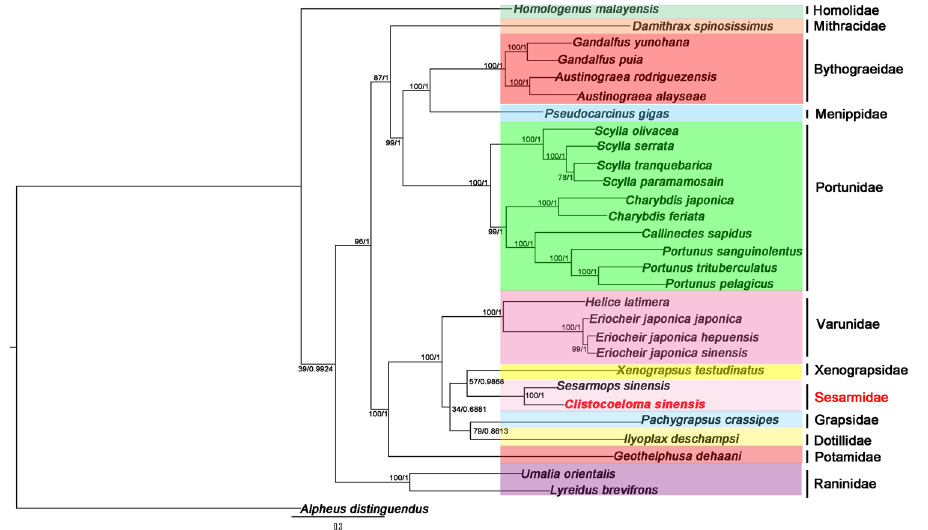
Figure 5. Inferred phylogenetic relationships among Brachyura based on nucleotide sequence of 13 mitochondrial PCGs using maximum likelihood (ML) and Bayesian inference (BI). Alpheus distinguendus was used as the outgroup. The bootstrap value (BP) and Bayesian posterior probability (BPP) of each node are shown as BP based on the NT dataset/BPP based on the NT dataset,